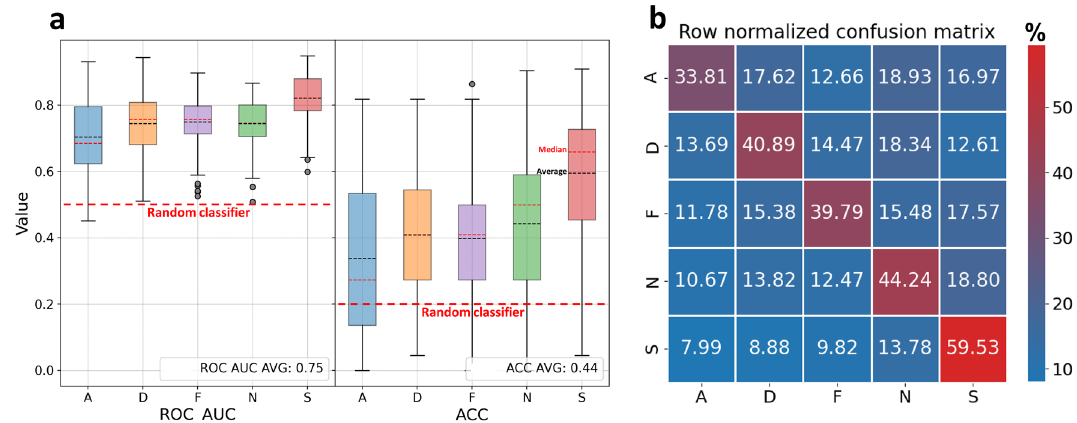
Figure 1. ( a ) The model’s statistical assessments used receiver operating characteristic area under the curve (ROC AUC) and subset accuracy (ACC) per emotion class: amusement (A), disgust (D), fear (F), sexual arousal (S), and neutral (N) as the baseline. The colored boxplot rectangles represent the interquartile range (IQR), which is equal to the difference between the upper and lower quartiles 26 . Values outside the 1.5 IQR range are marked with gray dots. The red and black dashed lines inside the IQR rectangles denote the median and average, respectively. The bold red dashed line labelled “Random classifier” marks the value of an unskilled classifier, similar to a coin-toss. ( b ) The row normalized confusion matrix displays the median of all LOOCV confusion matrix results, which were then row normalized (the sum of the values of each row is space, varying in the range of 0.5–1, where 0.5 is a random guess, and 1 is a perfect classifier. On the other hand, the ACC measure is based on the classifier’s final decision regarding to which class exactly each examined face video belongs according to the best probabilities threshold, varying in the range of 0–1, where 0.2 is a random guess (for a 5-class classification problem), and 1 is a perfect classifier. The row-normalized confusion matrix (Fig. 1b) presents the classifications results per emotion class, averaged over all the 110 LOOCV iterations. According to this measure, it seems that the classifier handled the sexual arousal class (S) best, followed by the neutral class (N), then disgust (D) with similar results to fear (F) and lastly amusement (A). Spatial feature importance analysis. The feature importance analysis was based on the loss function change (LFC) approach, built in the CatBoost classifier Python package by Yandex, in which the feature space is evaluated using the difference between the loss value of the model being trained, both with and without each of the features’ parameters. Thus, unique, first-of-their-kind (as far as we know) facial spatial feature importance distribution maps were yielded, along with intriguing temporal- and wavelength-related feature importance findings (Figs. 2, 3, 4, 5, 6). Classification tasks with k classes can yield k k − 1 2 binary classifiers: one class versus each one of the other classes. Therefore, our 5 classes can yield a total of 10 binary classifiers. Spatial feature importance maps are presented in Fig. 2 for each of those 10 binary classifiers. The letters denoting each of the emotions mark the different rows and columns, with the result that each of the maps is marked by two letters, which are the two classes of the binary classifier. For example, Fig. 2 shows that amusement (A) vs. sexual arousal (S) and amusement vs. fear (F) seem to have most of the region of importance (ROIm, i.e., hotspots) around the cheeks, while amusement vs. disgust (D) present a significant ROIm on the lower forehead or between the eyebrows. In addition, it appears as if the binary classifiers disgust vs. sexual arousal and neutral (N) vs. sexual arousal are both more heavily dependent on the non-spatiotemporal estimated heart rate (EHR) frequency (i.e., F8), since their overall summaries presented above each spatial map are 82.03% and 81.99%, respectively, while the rest of the importance belongs to F8. To quantify these, we defined regions of interest around the forehead, left and right eyes, left and right cheeks, and mouth (presented in Fig. 4b,c) and extracted mean feature importance values across pixels. The mean value for amusement vs. fear classification was higher in the cheeks (M = 0.158, SD = 0.002) vs. the rest of the face (M = 0.099, SD = 0.002), p < 0.001. The mean value for amusement vs. sexual arousal classification was higher in the cheeks (M = 0.130, SD = 0.002) vs. the rest of the face (M = 0.085, SD = 0.002), p < 0.001. The mean value important for amusement vs. disgust arousal classification was higher in the forehead (M = 0.235, SD = 0.005) vs. the rest of the face (M = 0.011, SD = 0.002), p < 0.001. The spatially distributed feature importance maps for each wavelength-dependent feature (F1–F7) that originate from the OvO multiclass classifications (averaged over all participants) are presented in Fig. 3, while the overall spatial importance averaged over all F1–F7 features is presented at the lower rightmost corner. As defined in Table 1, F1 represents the spatial facial ROIm distribution related to temperature changes, extrapolated from the thermal camera. F2–F4 and F7 represent the R, G, B and NIR pulsatile amplitude spatial importance, respectively. It seems that F2 ROIm is mostly around the mouth, F3 ROIm is mostly around the eyes, F4 ROIm is mostly located on the cheeks and lower forehead between the eyebrows, and F7 ROIm is mostly around the